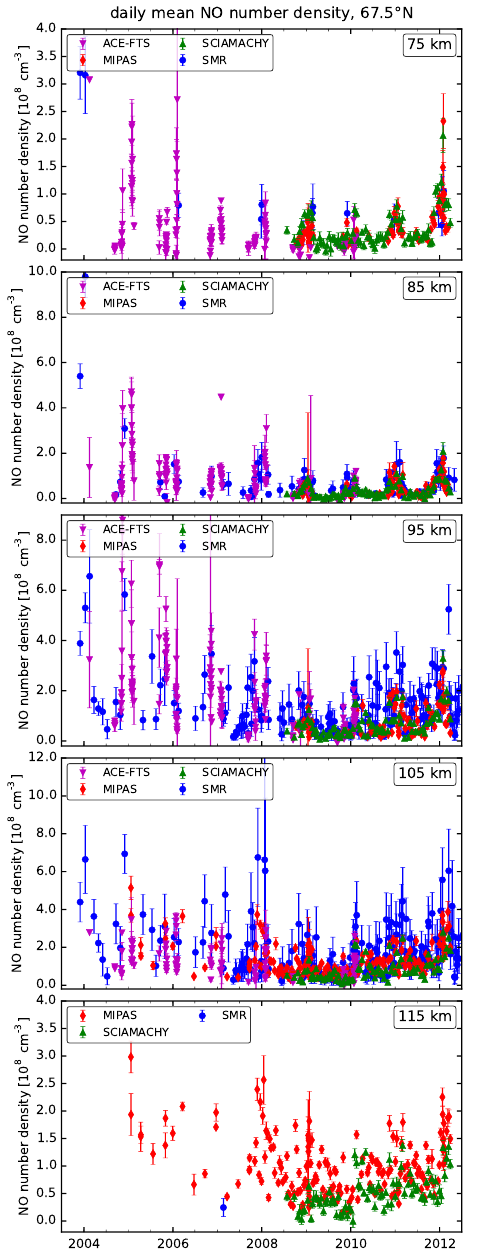
Figure B2. NO time series comparison of all four instruments at 67.5 ◦ S, for 75km, 85km, 95km, 105km, and 115km (from top to